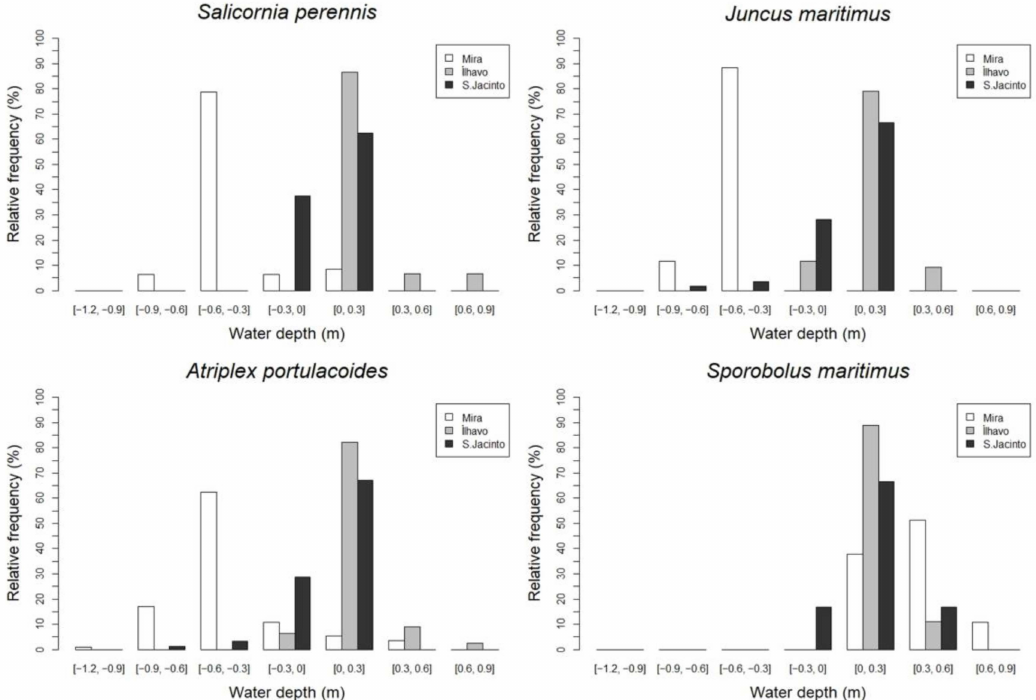
Figure A5. Water depth (WD (m)). Relative frequency distribution of the main species regarding the water depth for each of the studied